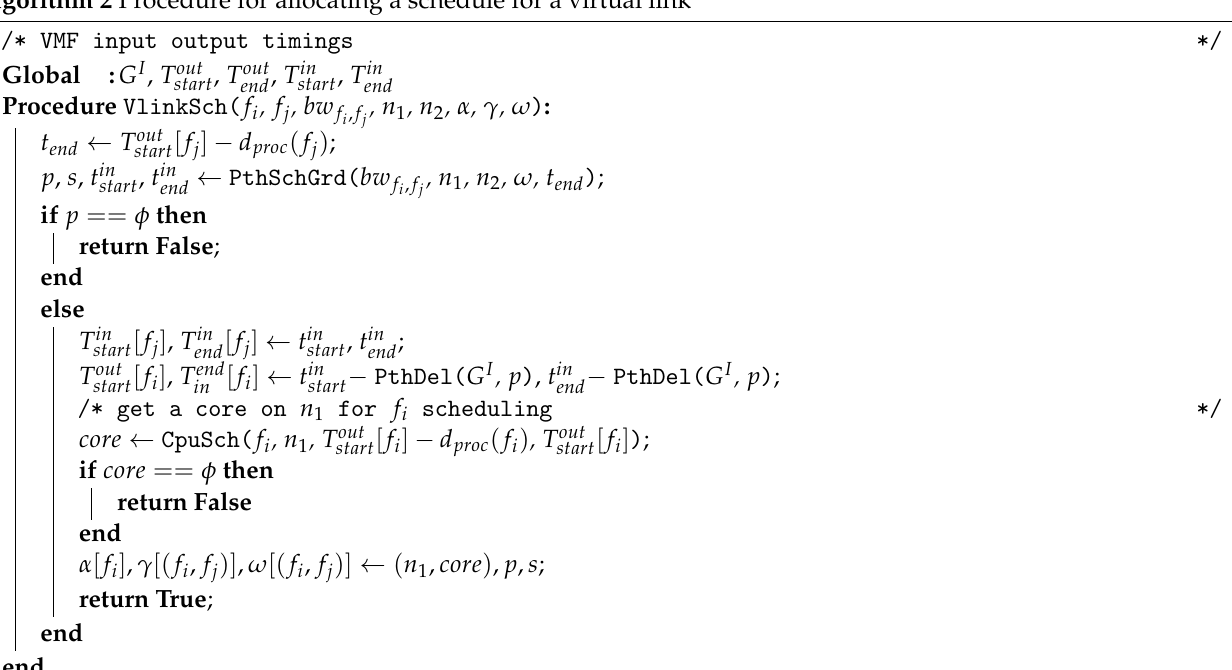
Algorithm 2 Procedure for allocating a schedule for a virtual link